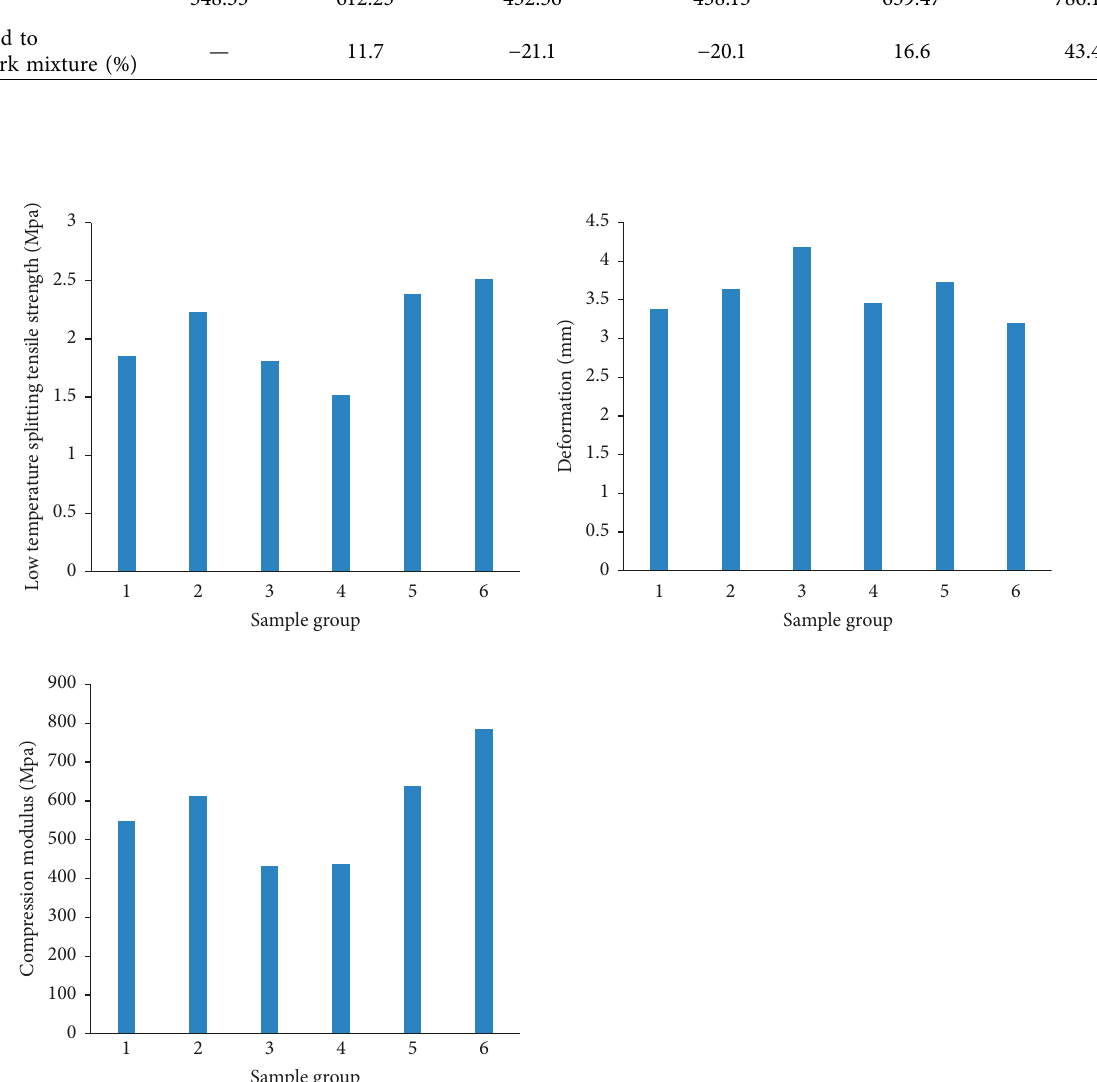
Figure 12: Column diagram of the results of low-temperature splitting